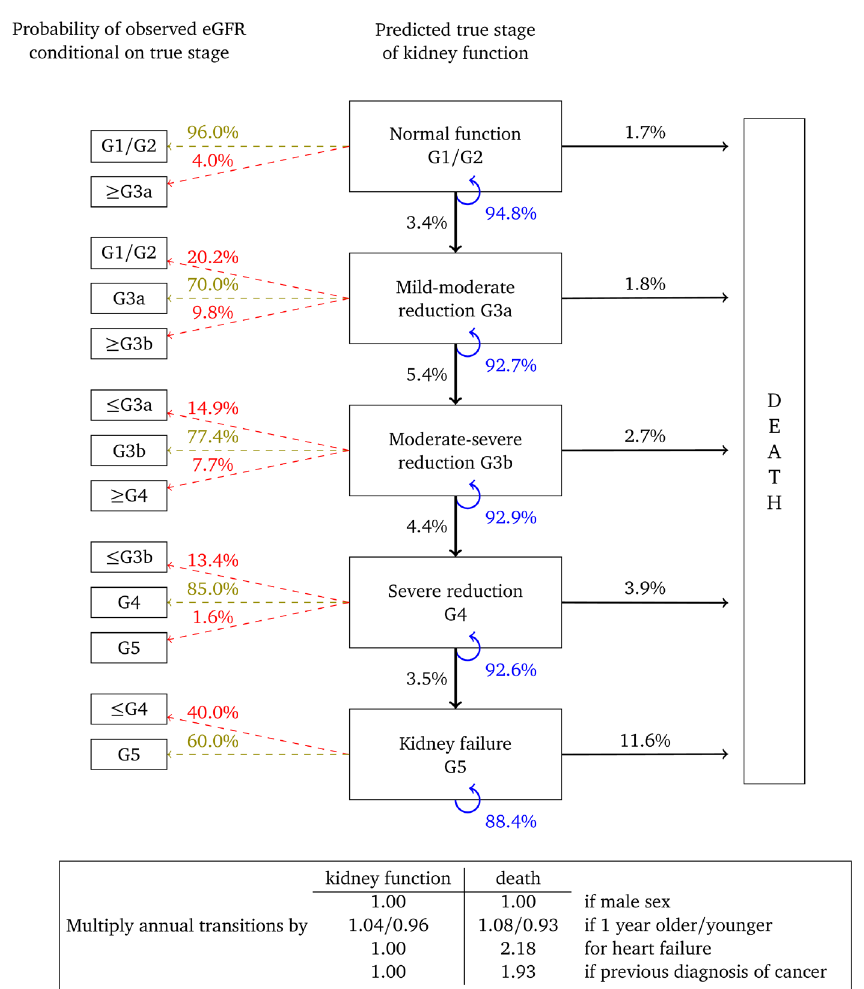
Figure 4. Annual transition model diagram for patients with microalbuminuria at baseline. Probabilities are based on a woman aged 60, without heart failure or a previous diagnosis of